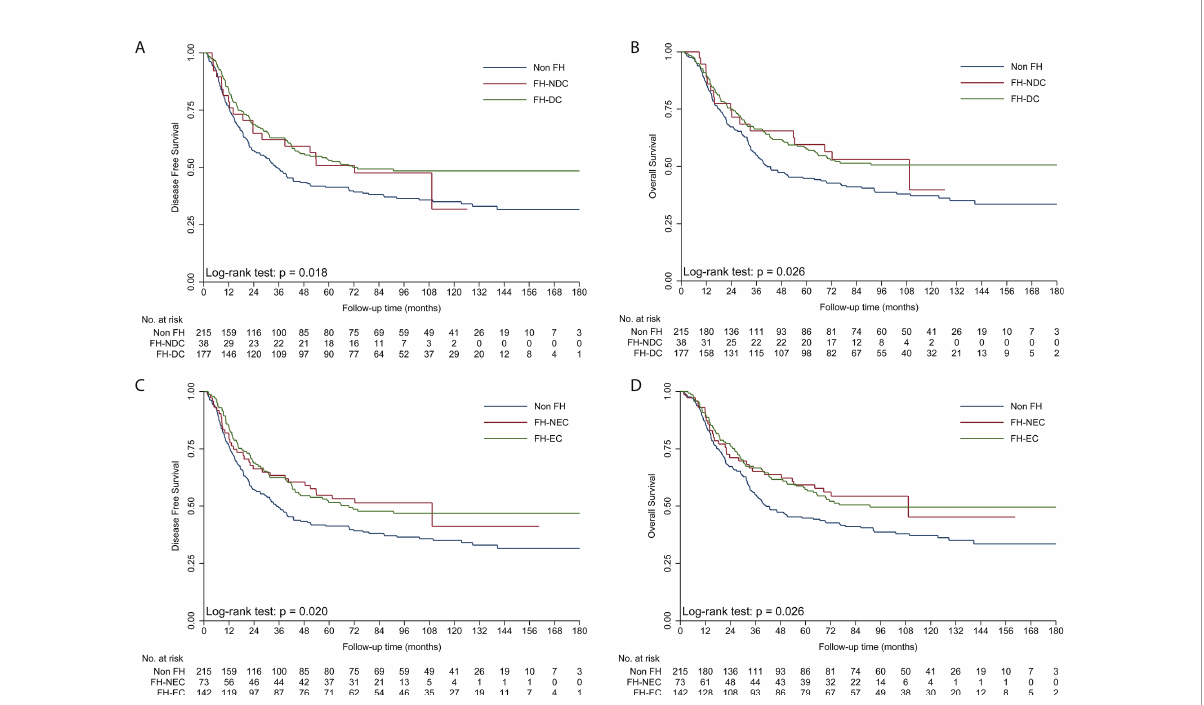
FIGURE 2 Kaplan – Meier curves showing better DFS (A) and OS (B) in the FH-DC group than in the non-FH group, but not in the FH-NDC group. Kaplan – Meier curves showing better DFS (C) and OS (D) in the FH-EC and non-FH groups. DFS, disease-free survival; FH, family history of cancer; FH- DC, family history of digestive tract cancer; FH-EC, family history of esophageal cancer; FH-NDC; family history of non-digestive tract cancer; FH-NFD, family history in non- fi rst-degree; OS, overall